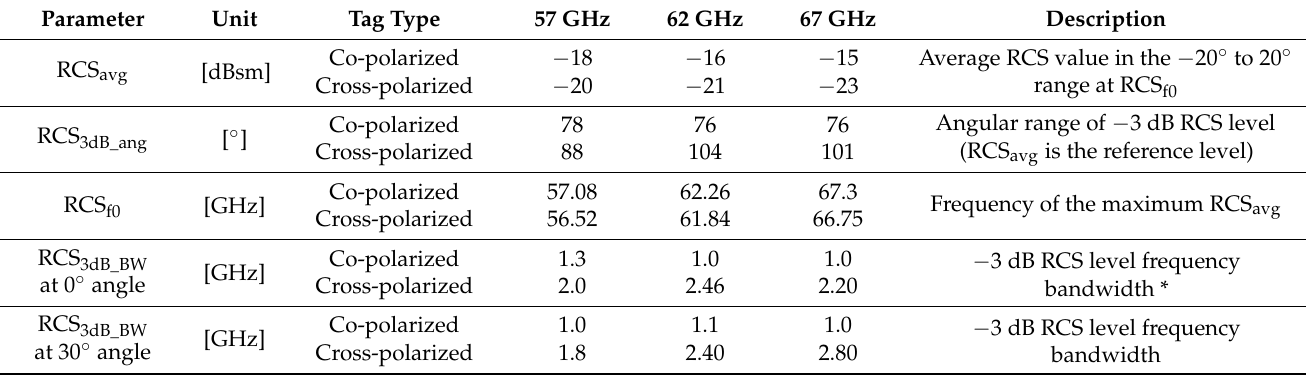
Table 3. Performance comparison of the measured co- and cross-polarized Van Atta array tags.